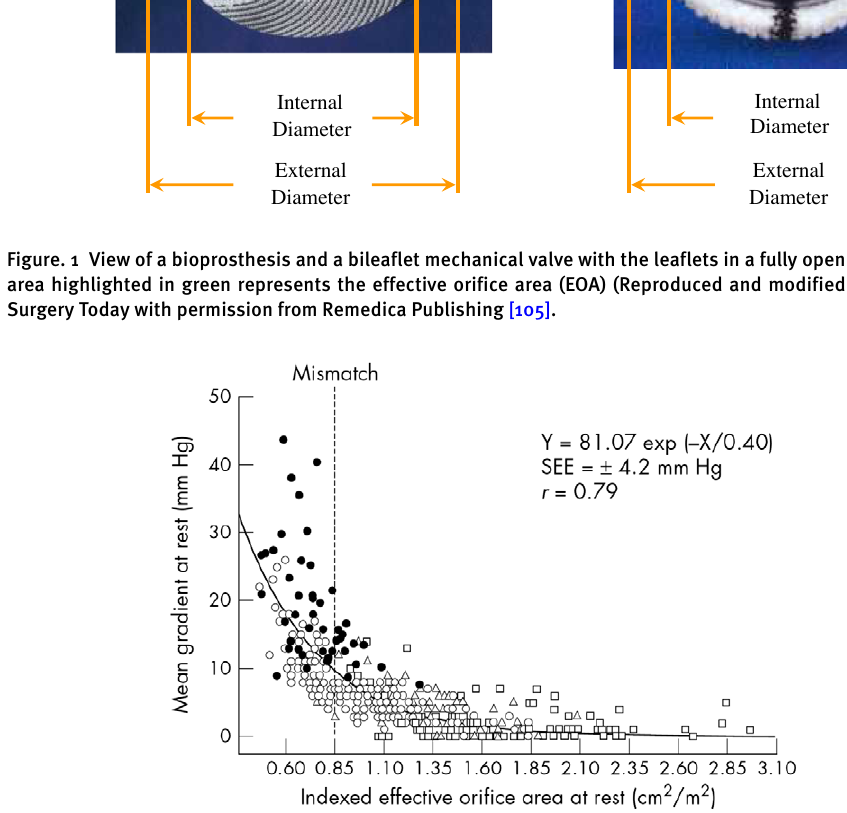
Figure. 2 Correlation between mean transvalvular gradient and indexed effective orifice area in patients with a stented bioprosthesis (n=51; • ), a stentless bioprosthesis (n=194; (cid:13) ), an aortic homograft (n=55; ∆ ), or a pulmonary autograft (n=96; (cid:3) ). Several points are overlapped (Reproduced with permission from